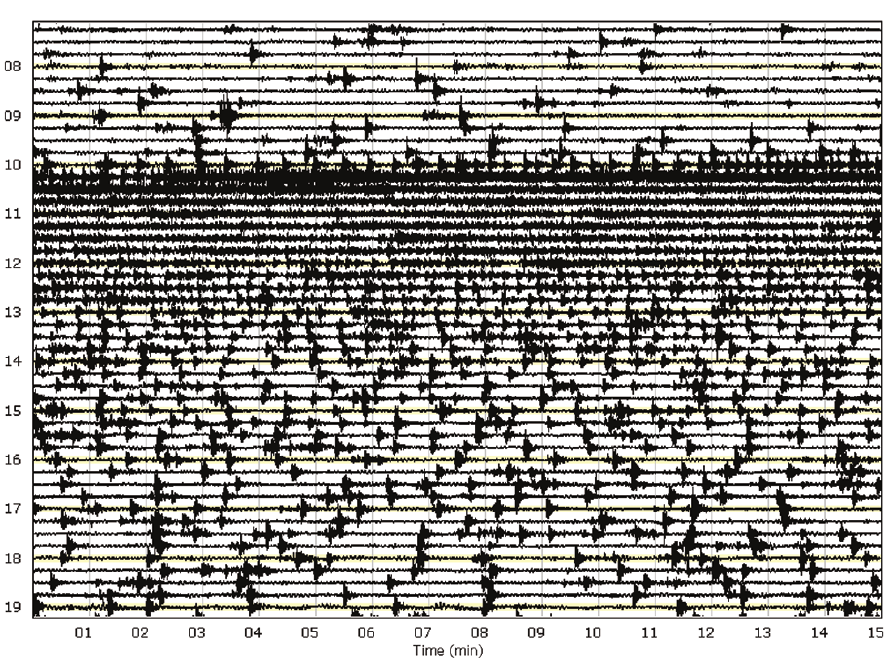
Fig. 15. The swarm of hybrid events recorded on March 20, 2007, by the STRA station (East-West component).